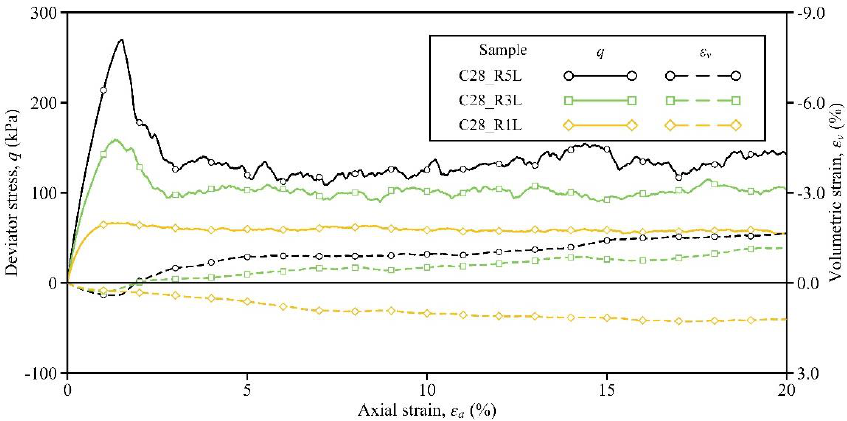
Figure 5. Influence of the cement – sand ratio on the stress – strain response.